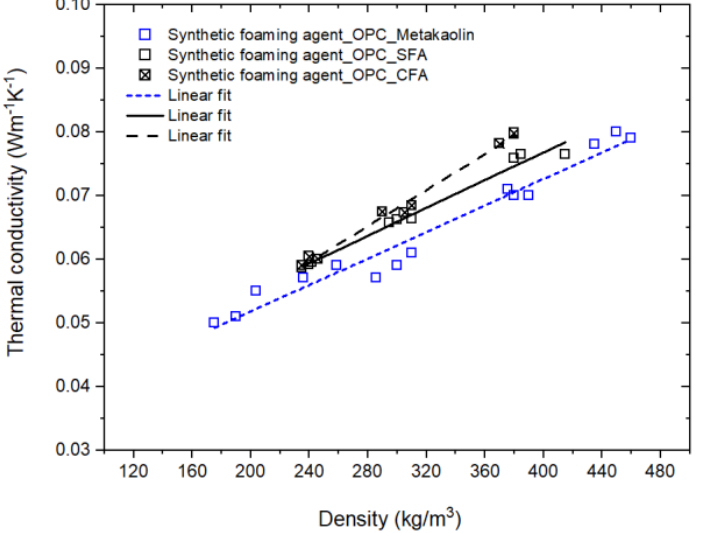
Figure 14. Thermal conductivity of foam concrete made of synthetic foaming with OPC mixed with metakaolin, SFA or CFA.